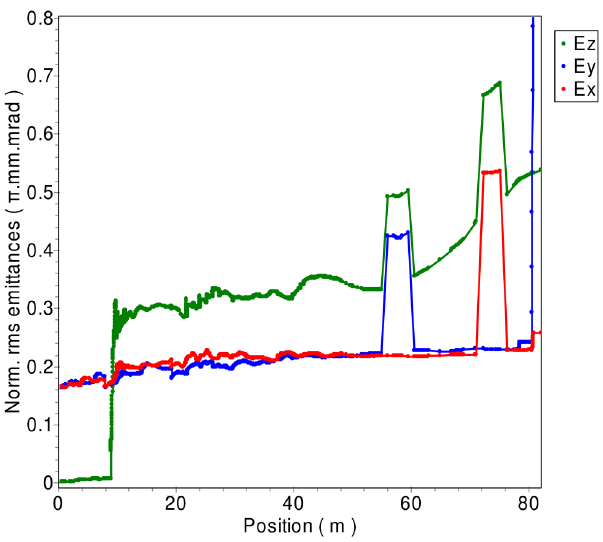
FIG. 4. (Color) Normalized rms emittance